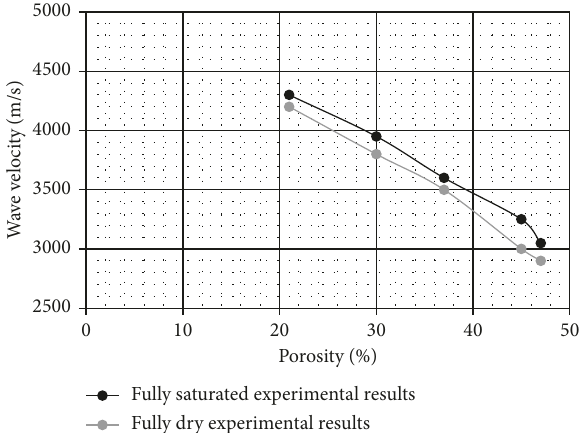
Figure 1: Experimental data of fully saturated and fully dry wave velocity with porosity